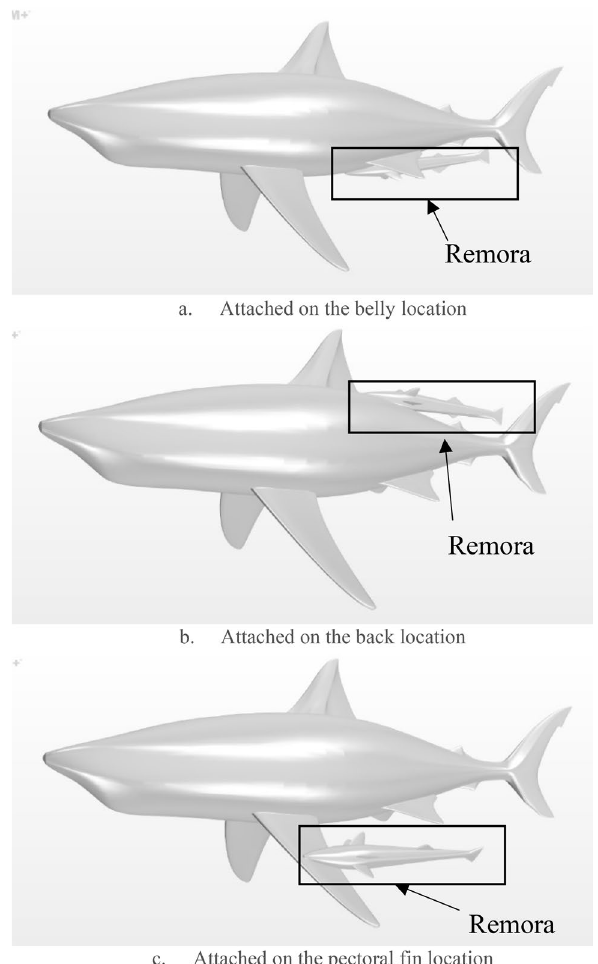
Figure 19. Attachment locations of the remora fish in the ( a ) belly, ( b ) back and ( c ) pectoral fin of the shark (Created using Simcenter STAR-CCM + 2019.2.1 Build